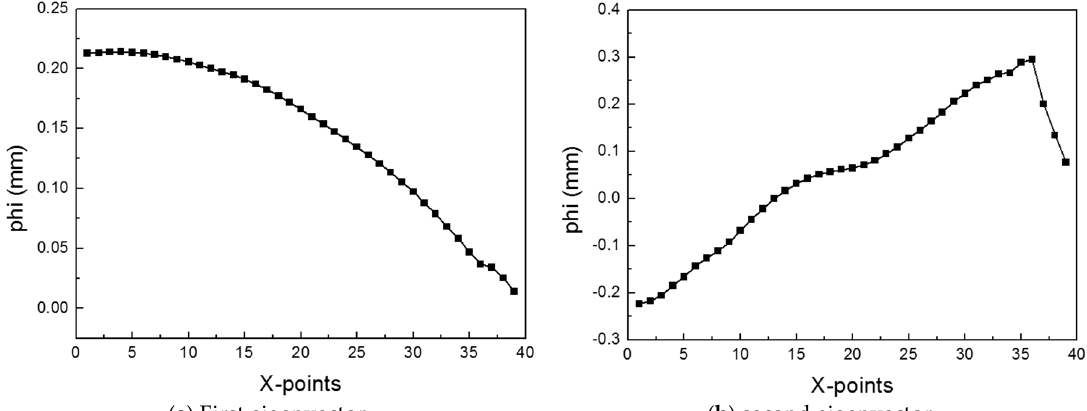
Figure 11. Dominant eigenvectors for the EHF simulation. Figure 10. Cumulative sum of eigenvalues. Materials 2019 , 12 , x FOR PEER REVIEW Figure 10. Cumulative sum of eigenvalues.